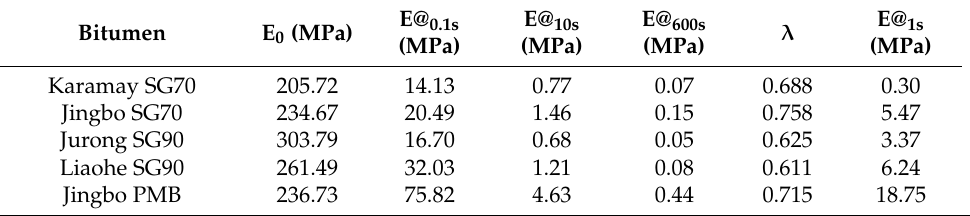
Table 7. Relaxation modulus at some specific times and the fitting results for various bitumen binders at − 10 ◦ C.